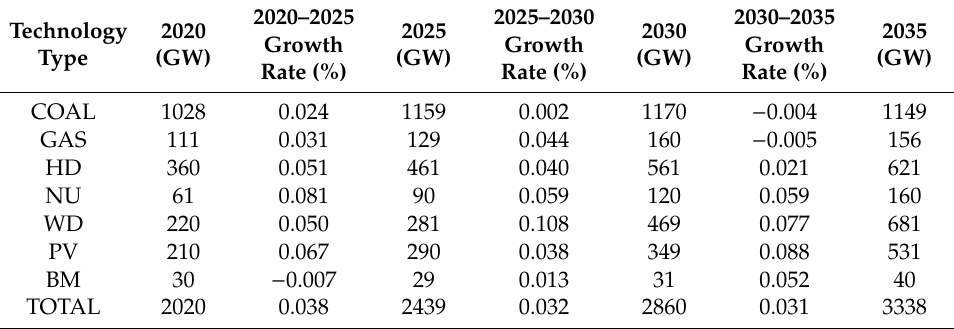
Table 5. Prediction of the installed generation capacity, by technology type, between 2019 and 2035.